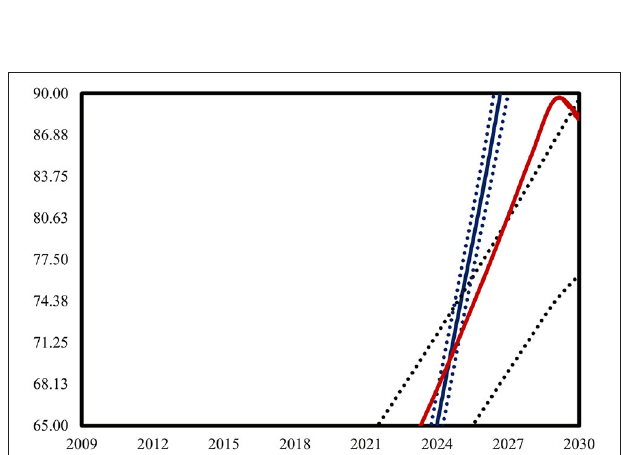
FIGURE 2 | Focus on the ETS CO 2 -equivalent (tCO 2 e) price dynamics of carbon allowances. The x -axis represents the time-line. The y -axis measures the option prices. The blue line corresponds to the levels of calls (optional purchasing prices). The blue dotted lines indicate the standard deviation of the calls. The red line corresponds to the levels of puts (optional selling prices). The black dotted lines depict the double-barrier optional values according to the public recommendations on carbon